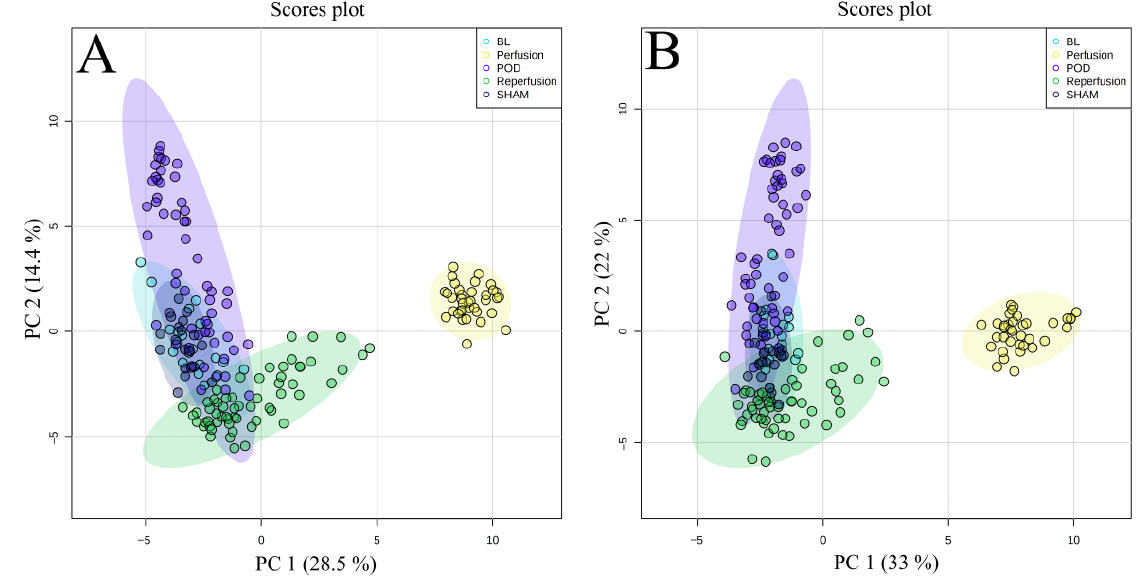
Figure 1. Score plots (PCA) showing separation indicating differences in the metabolomic patterns of the samples based on the time interval at which they were collected. ( A ) positive ionization mode, ( B ) negative ionization mode.